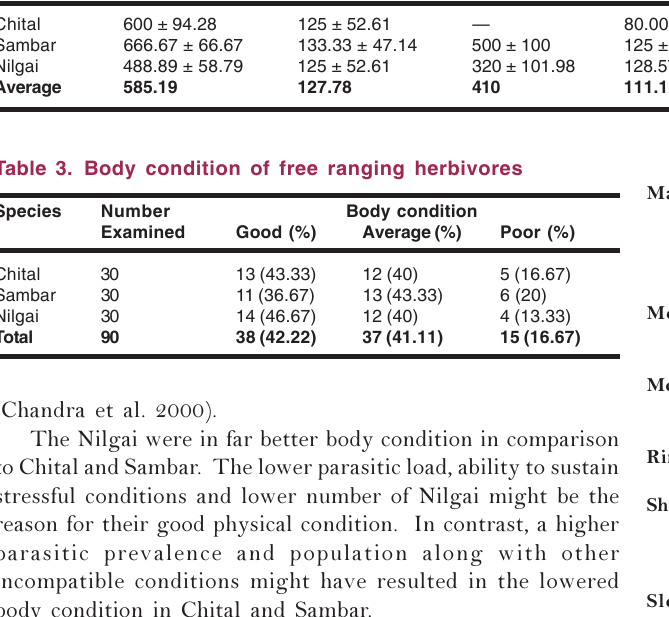
Table 2. Overall mean EPG/OPG of parasites in free ranging herbivores Species Strongyles